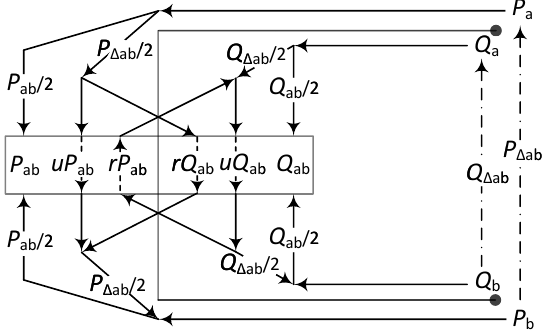
Figure 3. Interphase power flow of a constant power